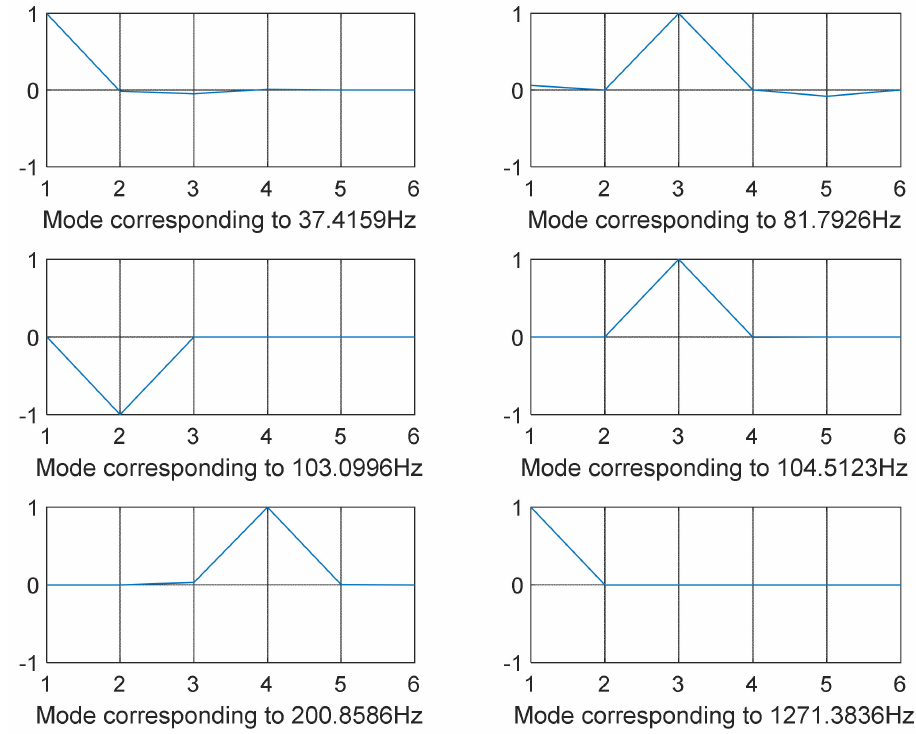
Figure 12. GA-optimized mode shapes 7–12 (12-DOF model—combined loading).